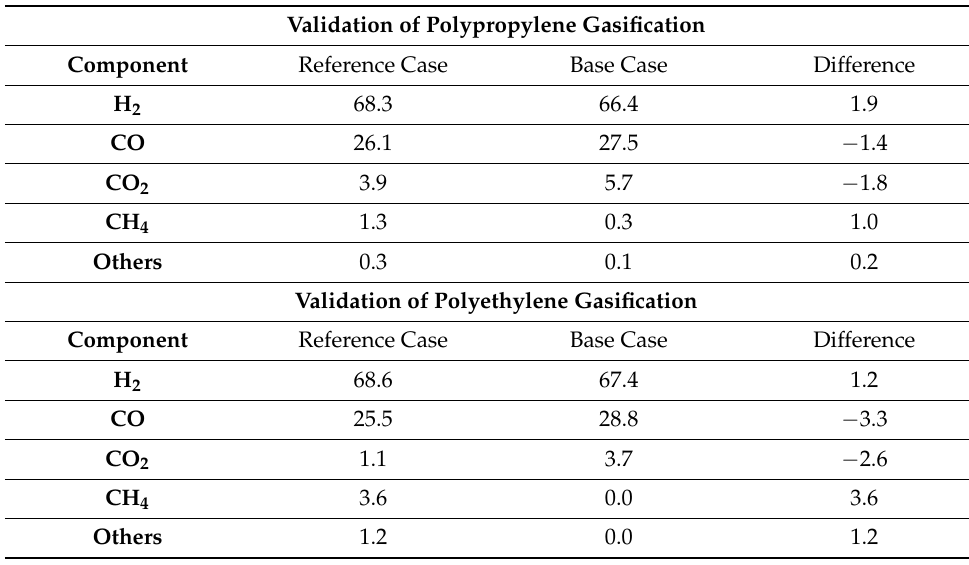
Table 3. Polyethylene and polypropylene gasification validation.